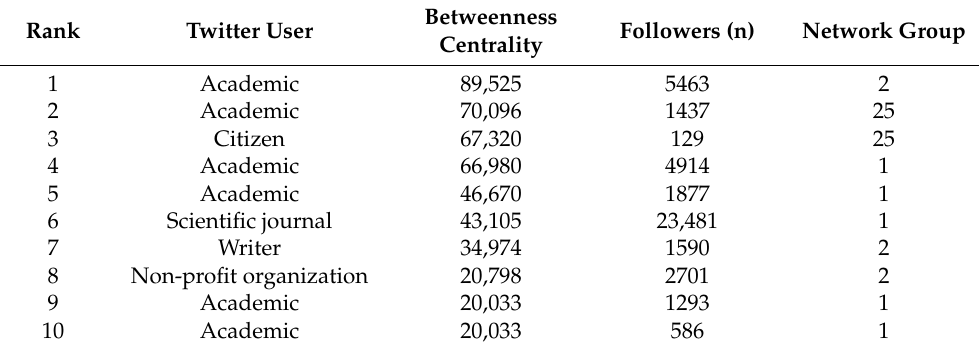
Table 2. Influential users ranked by their betweenness centrality score (25 January 2022).